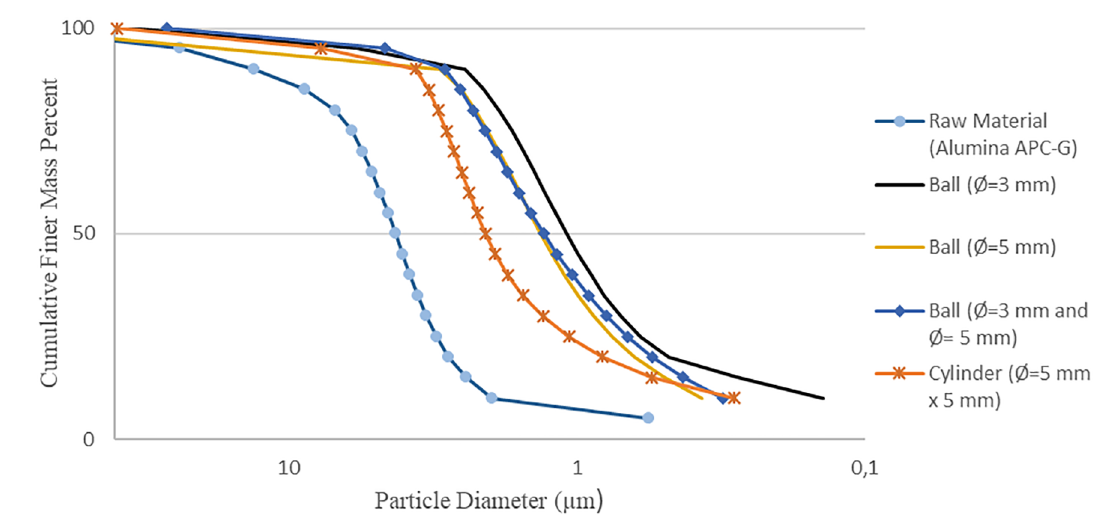
Figure 2. Cumulative particle size distribution: effect of media size and shape.